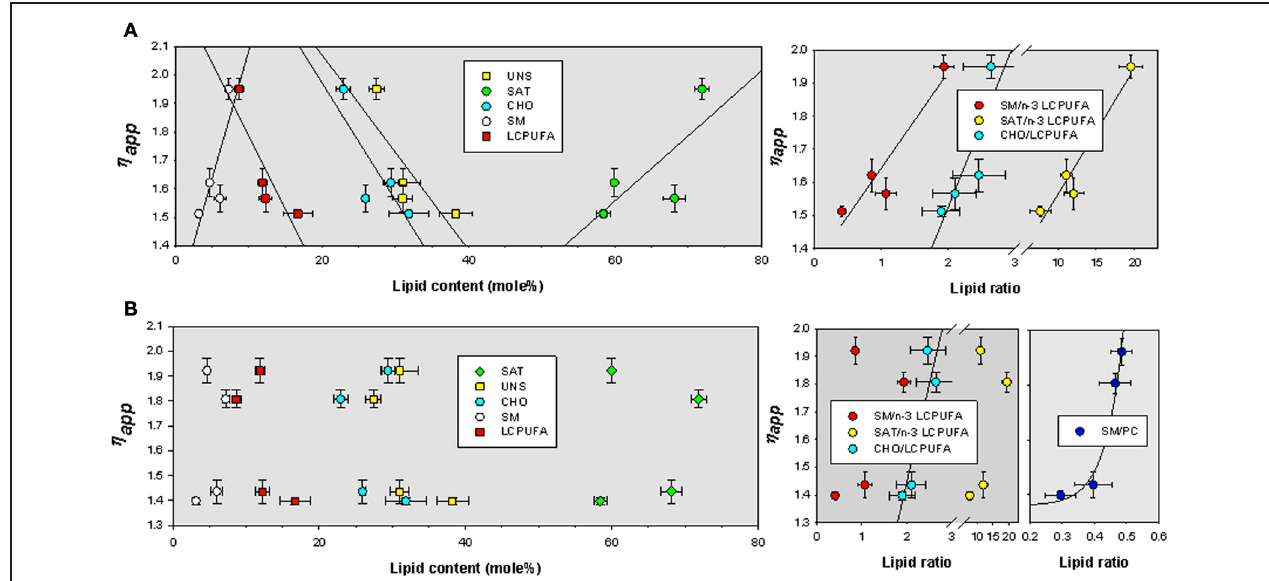
FIGURE 5 | Bivariate relationships for η app as a function of lipid classes and lipid indexes for TMA-DPH (A) and DPH (B) in lipid rafts isolated from APP/PS1 and WT animals. SAT, total saturates; UNS, total